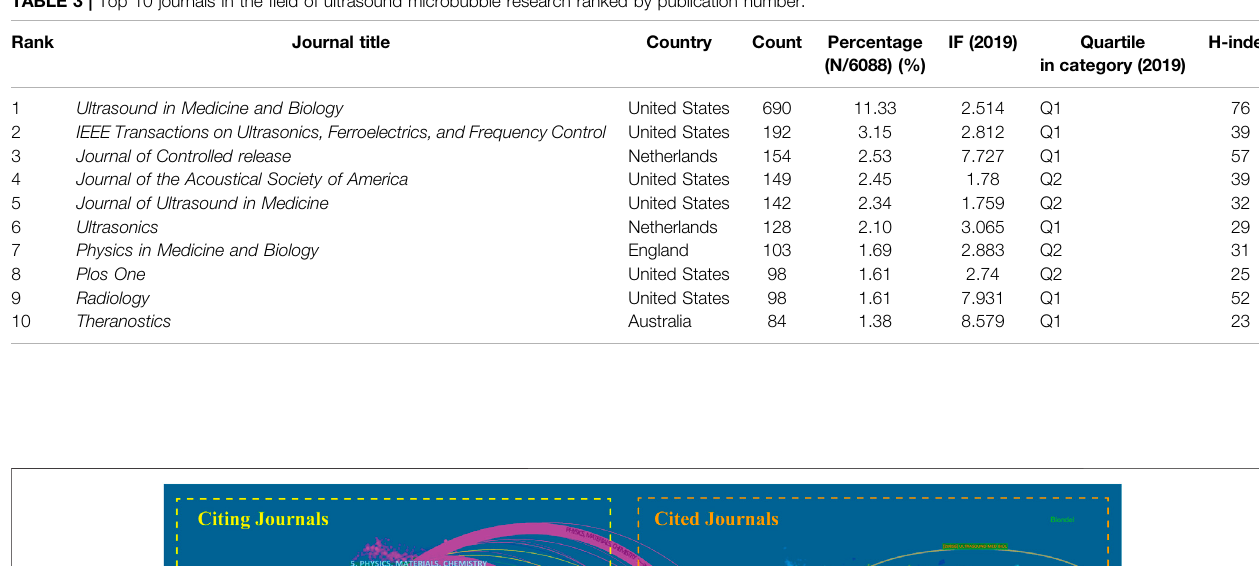
TABLE 3 | Top 10 journals in the fi eld of ultrasound microbubble research ranked by publication number.